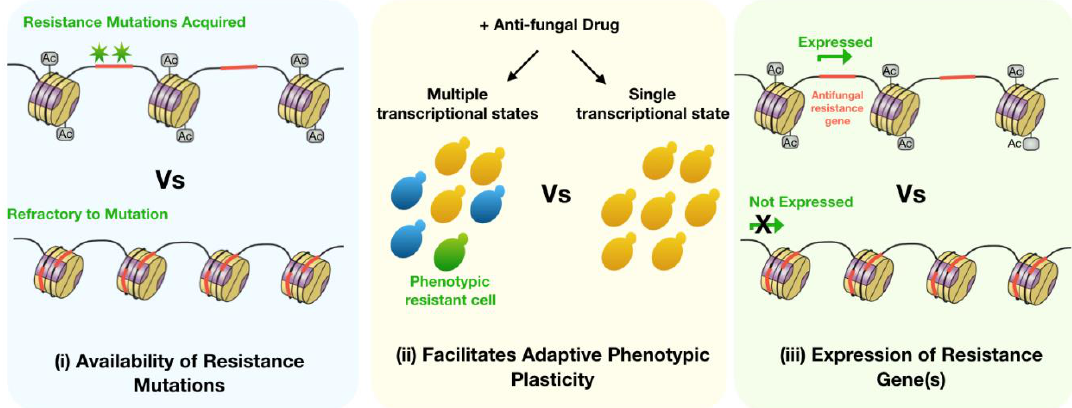
Figure 1. Potential mechanisms for how chromatin state influences anti-fungal resistance in Candida spp. ( i ) Di ff erences in the accessibility of DNA throughout the genome, dictated by chromatin state, can impact where genetic variation may occur. This means that chromatin may potentially control the availability of specific anti-fungal resistance mutations (green stars). ( ii ) Phenotypic plasticity allows certain Candida ssp. to display altered phenotypes in response to environmental cues and gives rise to population heterogeneity (indicated by di ff erent coloured yeast cells). Phenotypic plasticity relies on the relaxation of barriers that regulate transcription, including chromatin structure, and can result in a transcriptional state that facilitates phenotypic resistance (green yeast cell). ( iii ) Chromatin structure directly regulates transcription and therefore can influence whether a given resistance mutation is expressed or not. Furthermore, certain anti-fungal resistance mechanisms rely on the overproduction of a normal gene, which can be sensitive to particular chromatin state(s). (Ac = acetyl group)